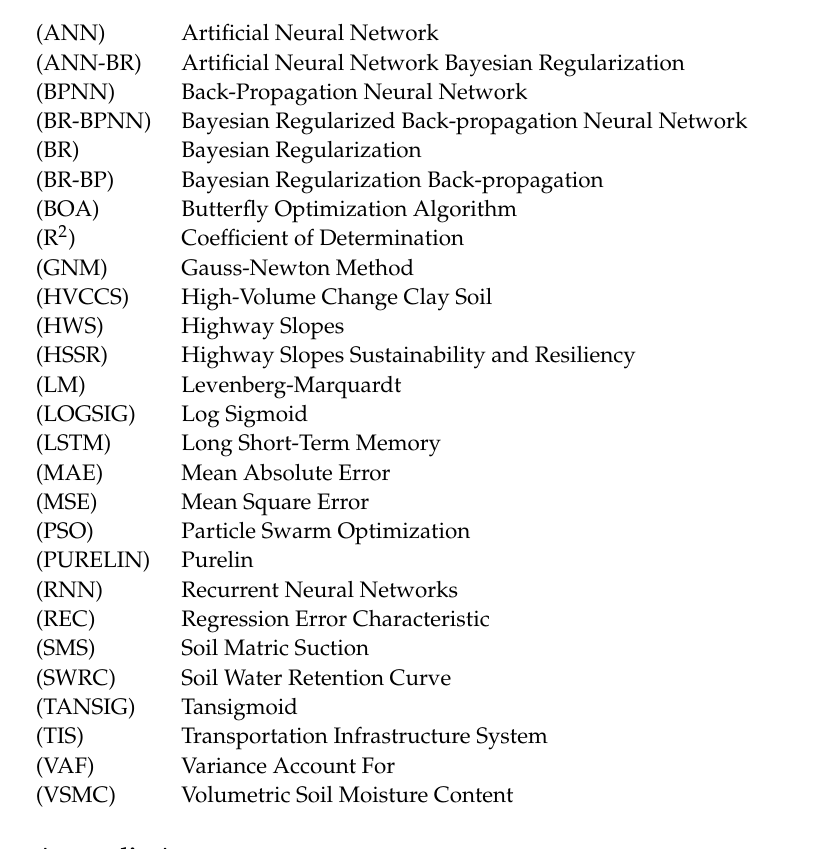
( f ) Figure A1. 3D in situ variation of rainfall, SMS, and VSMC at 3 m depth ( a ) HWS 1 ( b ) HWS 2 ( c ) HWS 3 ( d ) HWS 4 ( e ) HWS 5 ( f ) HWS 6. ( a ) ( b )